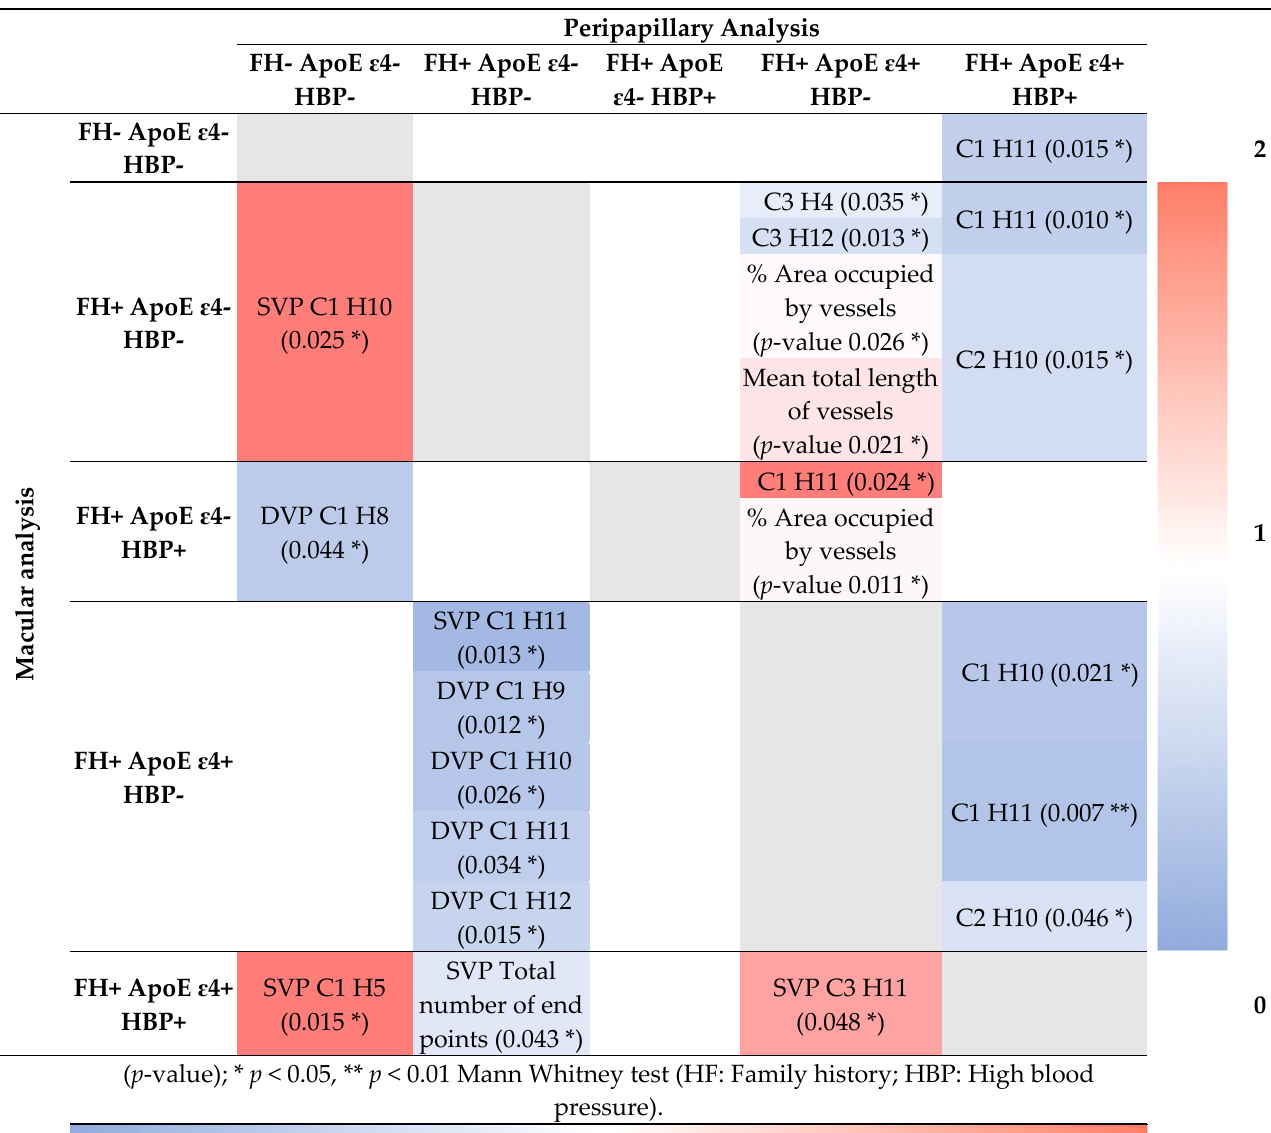
Table 3. Vascular density according to family history of AD and the allelic characterization of ApoE and HBP using AngioTool and EA-Tool.